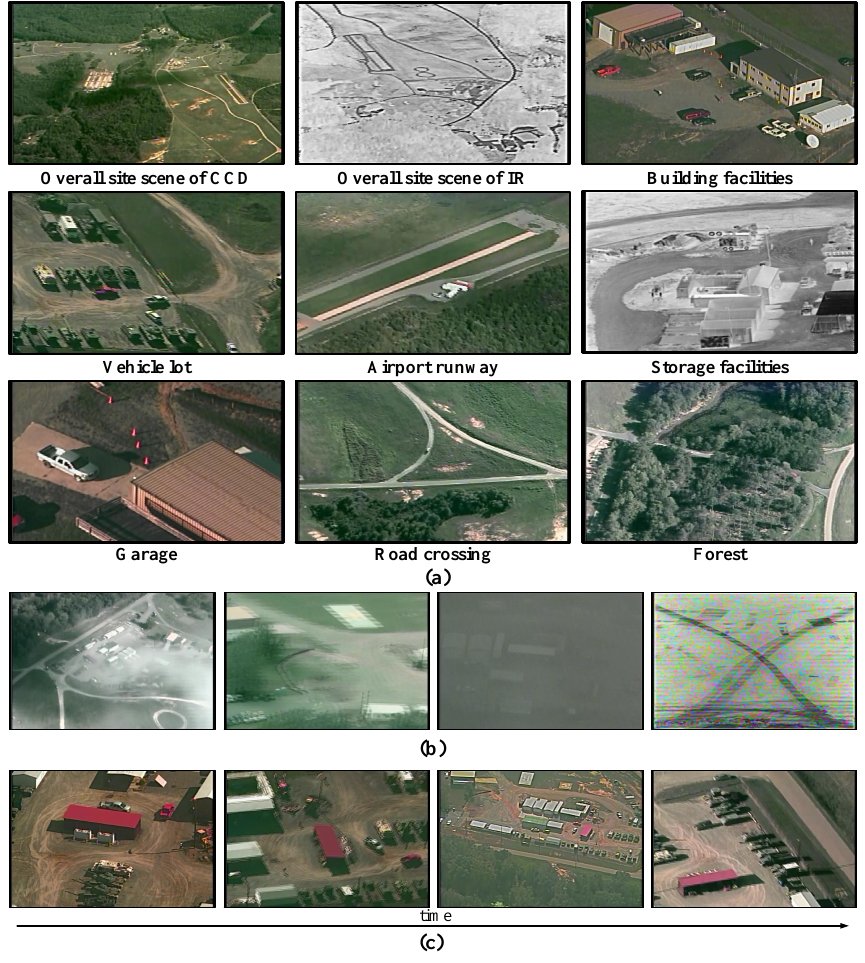
Figure 1. Examples of the large-scale VIRATaerial dataset [17], which includes images selected from 25-h realistic aerial videos. The dataset is published in [17] and available from www.viratdata.org. ( a ) Diverse scenes of VIRAT aerial dataset. ( b ) Sample image shots with clouds, motion blur, low contrast and camera noise. ( c ) Sample image shots with varying scales and viewpoints over